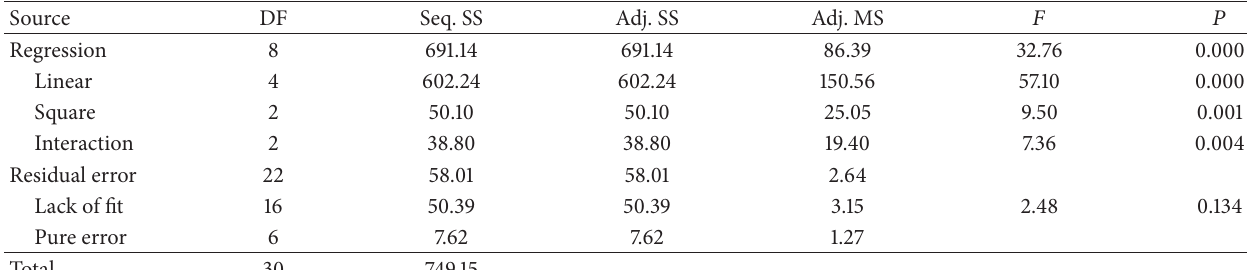
Table 5: ANOVA for significant interactions.